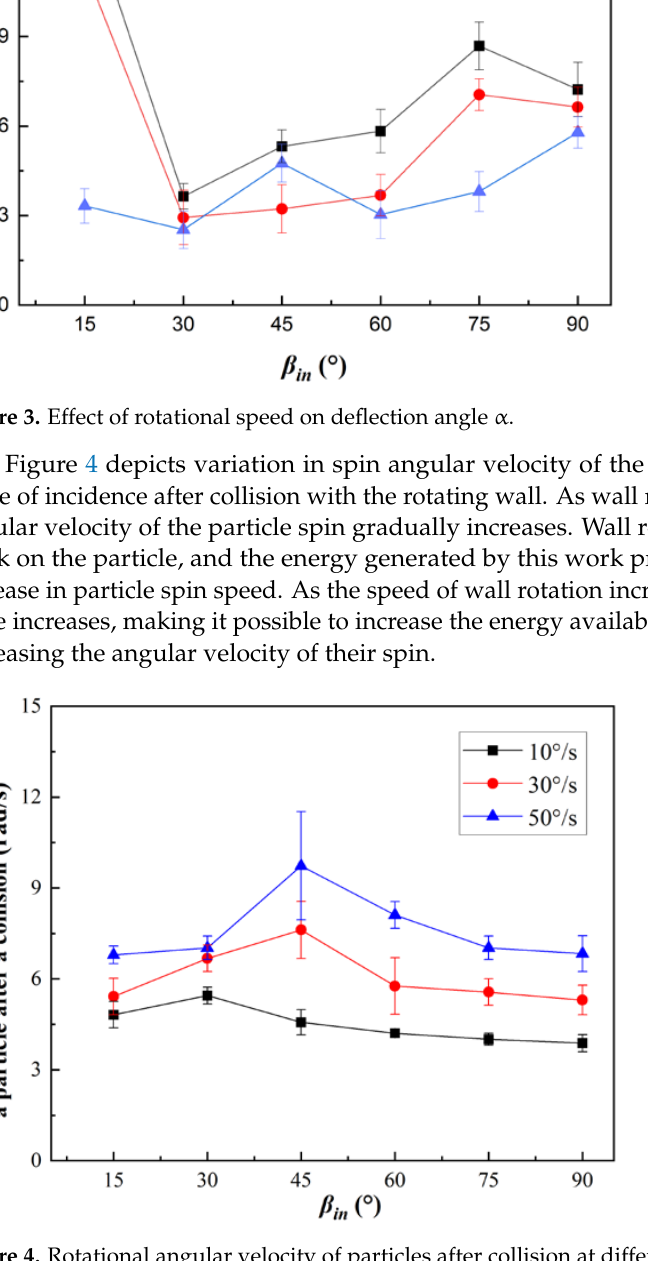
Figure 4. Rotational angular velocity of particles after collision at different rotational